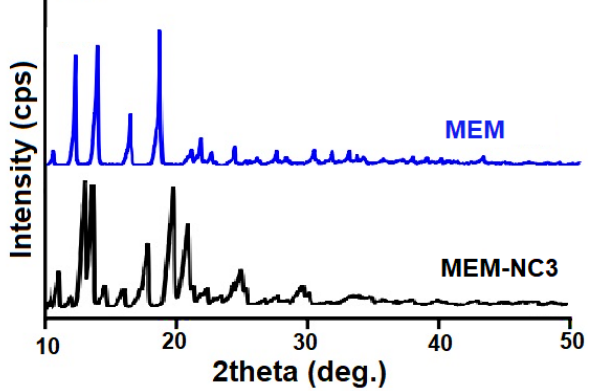
Figure 3. PXRD pattern of MEM and MEM-NC3 (aka MEM/CS-NC3).